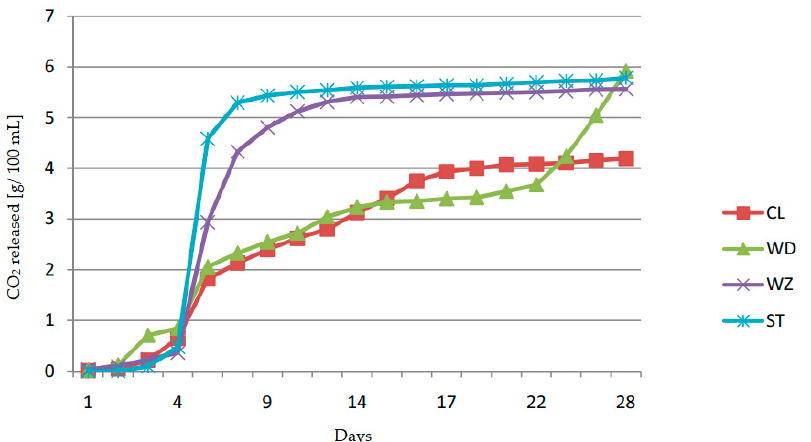
Figure 1. Fermentation dynamics of plum must fermented spontaneously, n = 5, STD < 5%. Abbreviations: CL— ˇCaˇcanska Lepotica, WD—W˛egierka D ˛abrowicka, WZ—W˛egierka Zwykła, ST—Stanley.